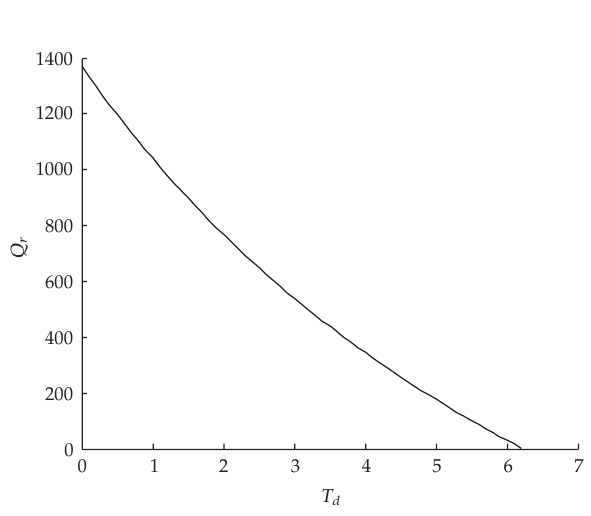
Figure 9: T r with respect to T d .